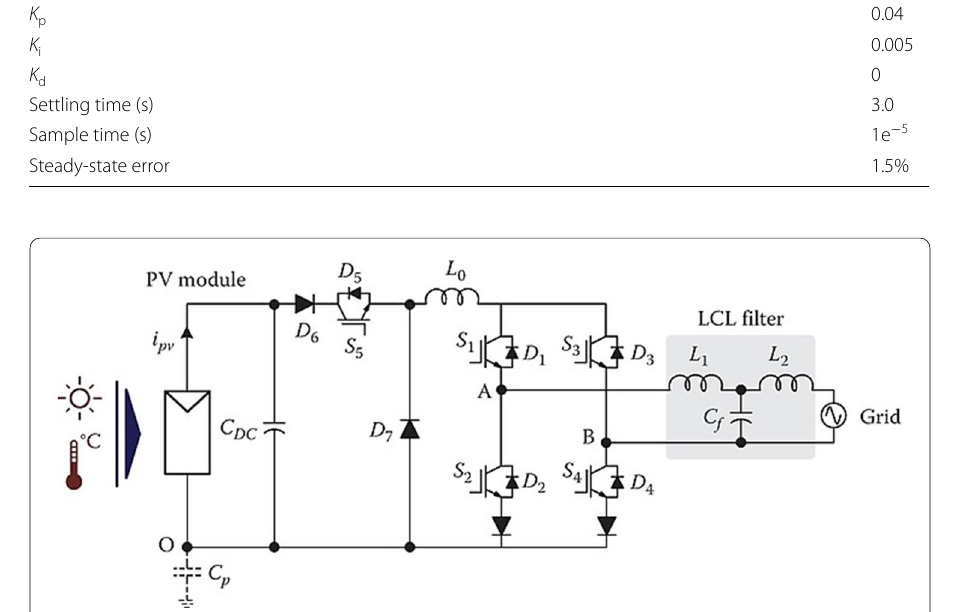
Fig. 9 A universal single-stage AC-module inverter with an LCL